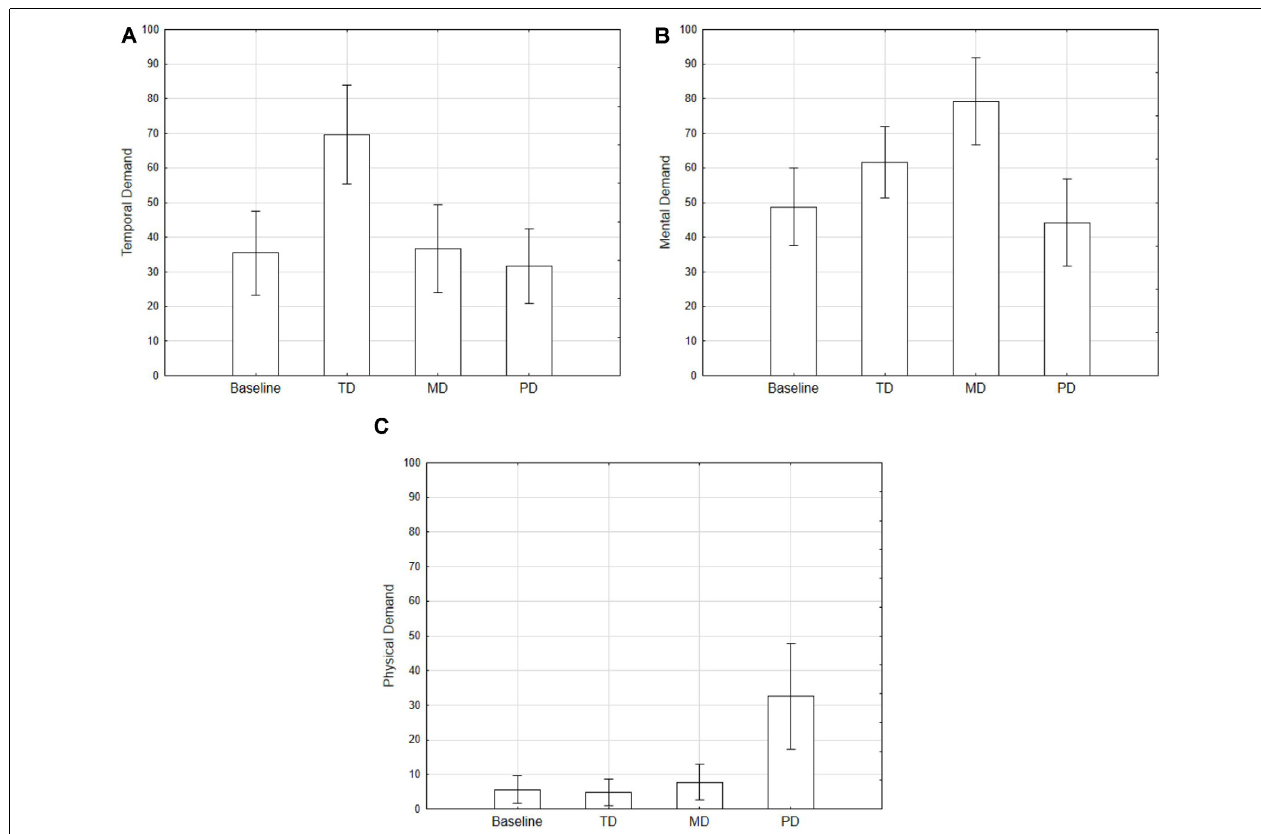
FIGURE 3 | NASA-TLX subscales values [Temporal (A) , Mental (B) , and Physical (C) demand] separately for the conditions. Error bars denote 0.95 confidence